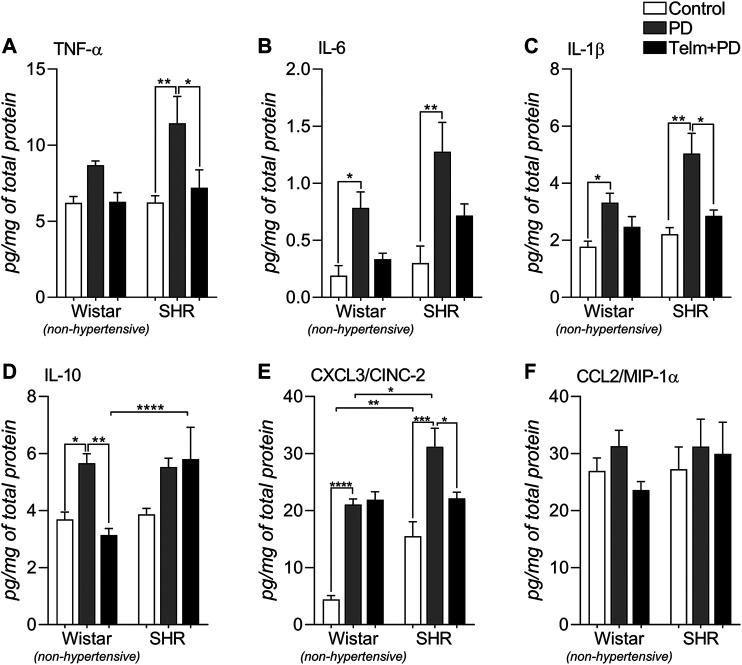
Inflammatory mediator production in mandibles of Wistar (non-hypertensive) and SHR with PD 15 d, treated with telmisartan. ELISA for TNF-α (A), IL-6 (B), IL-1β (C), IL-10 (D), CXCL3/CINC-2 (E) and CCL20/MIP-1α (F). Graphs shown mean ± SEM (n = 6). Statistical difference are represented by brackets labeled by *p < 0.05, **p < 0.01, ***p < 0.001, and ****p < 0.0001, comparing Control vs. PD, PD vs. Telm + PD, and Wistar vs. SHR in the same experimental condition.